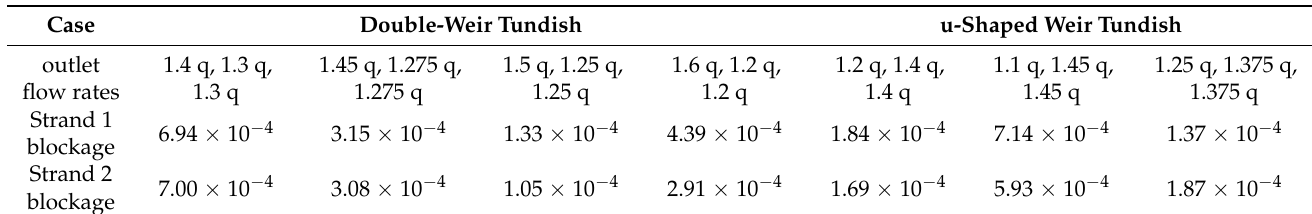
Table 6. Time average variance of outflow percentage of each strand with non-uniform increasing casting flow rate under single-strand blockage conditions of two tundish designs.